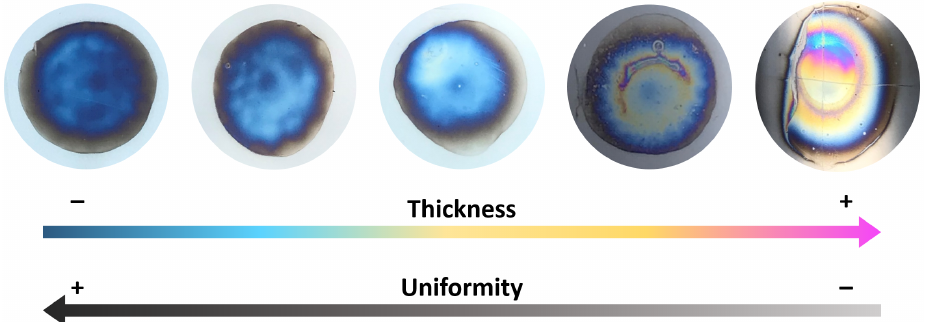
Figure 10. Relationship between thickness and uniformity of the pp